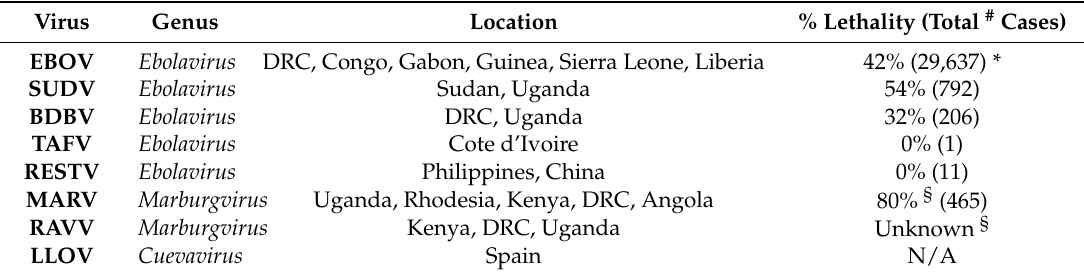
Table 1. Location and lethality of filovirus disease